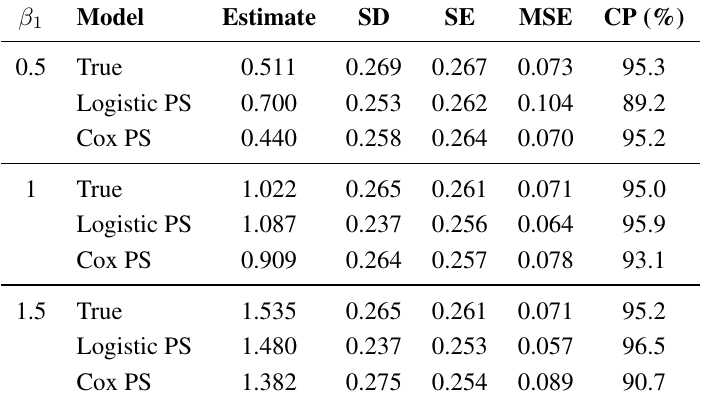
Table 2. Second scenario of simulation: every subject has a potential exposure time, some occurred after end of pregnancy. β 1 Model Estimate